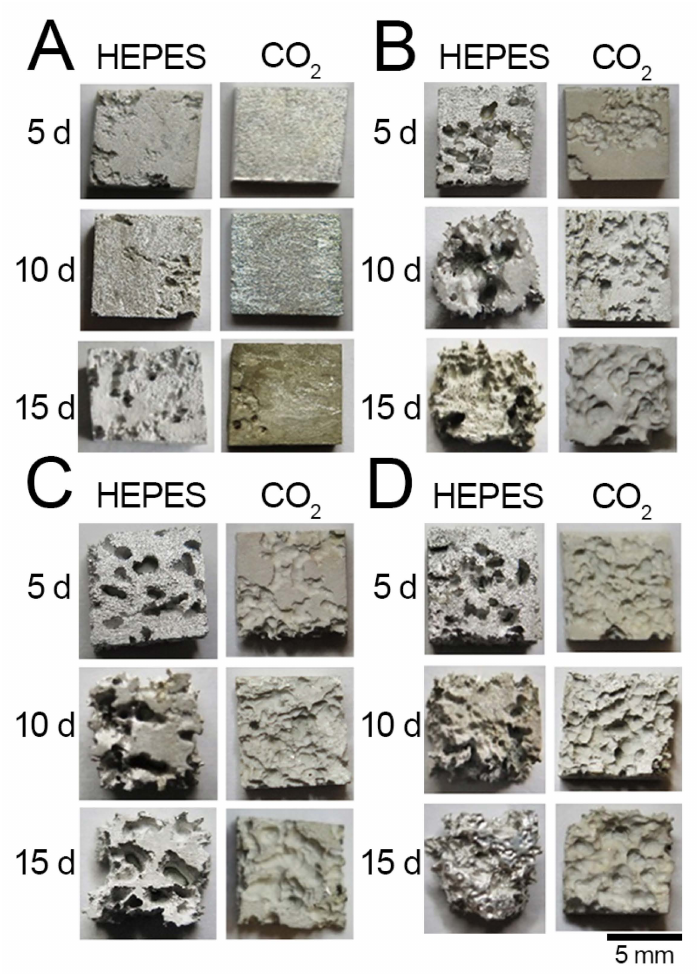
Figure 3. Photographs of the corroded surfaces of ( A ) AC, ( B ) R30, ( C ) R40 and ( D ) R50 following immersion testing after 5, 10 and 15 days in HEPES-buffered or NaHCO 3 /CO 2 -buffered (CO 2 ) EBSS. Corrosion products were removed from the surfaces with chromic